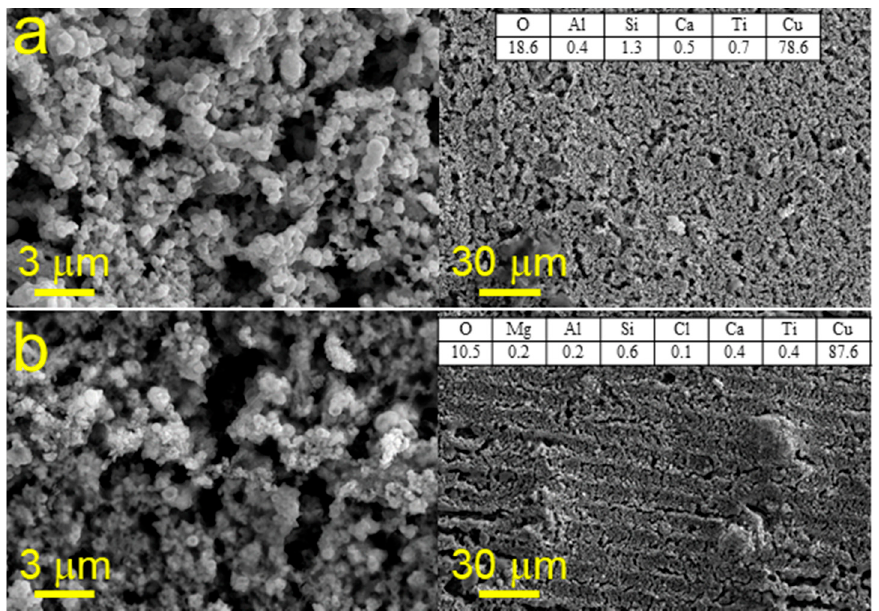
Figure 2. SEM images and results of EDX analysis (right top corner in each panel) of Cu patterns fabricated on glass-ceramics using SLS at the laser fluence of 0.0192 J/cm 2 along with the scanning speed of 5 ( a ) and 10 ( b ) mm per second.